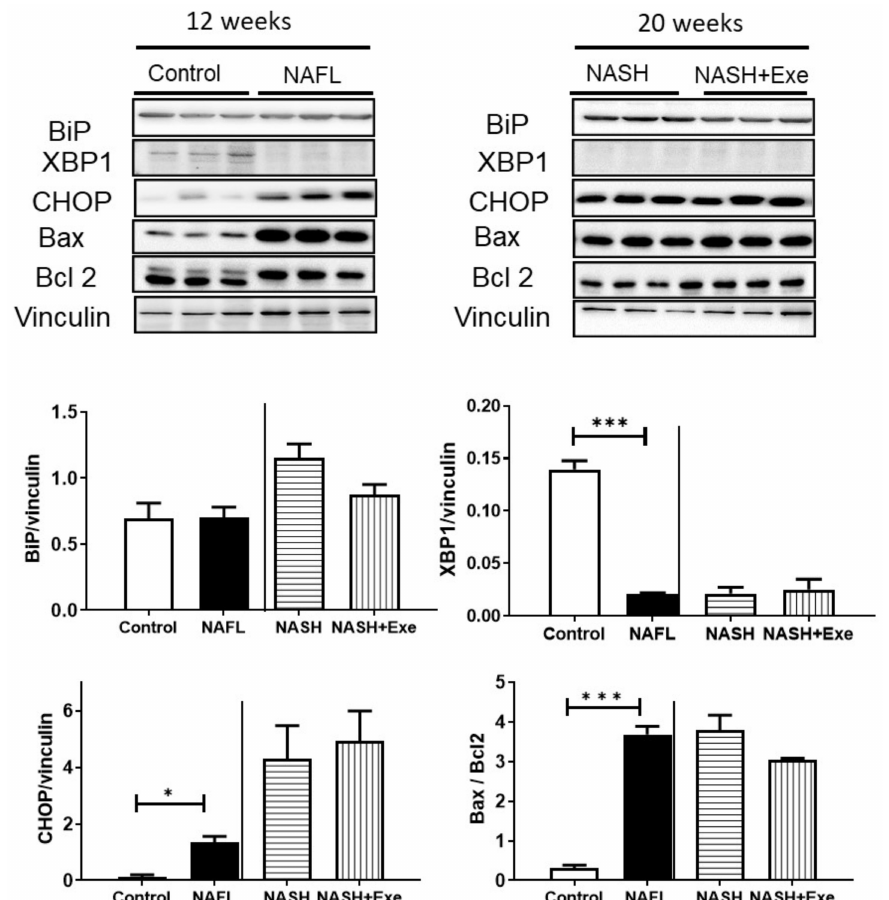
Figure 7. E ff ect of diet and exercise on endoplasmic reticulum (ER) stress and apoptosis. Immunoblots (upper panel) and quantification (lower panel) of proteins expressed in livers from control, NAFL, NASH, and NASH + EXE groups. Comparisons were made between the control and NAFL groups at 12 weeks, and between the NASH and NASH + EXE groups treated for 20 weeks. Binding immunoglobulin protein (BiP) was not di ff erent between groups. X-box binding protein (XBP-1) was lowered in NAFL vs. control and remained very low in both NASH groups. C / EBP homologous protein (CHOP) expression was higher in NAFL than in controls and increased further in the NASH groups. The ratio of Bcl-2 associated X protein (Bax) to Bcl-2 was elevated in NAFL vs. control but was not significantly changed by exercise. Vinculin served as the loading control. Groups are as described in Figure 1 (unpaired t -test; * p < 0.05; *** p < 0.001). For more details of Western blots, please view Figure